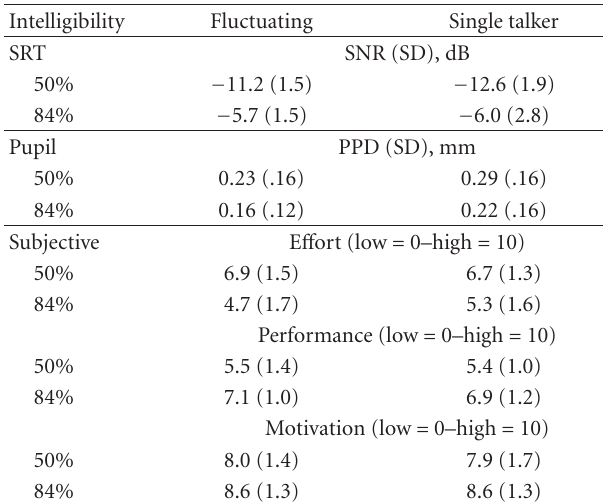
Figure 2: Pupil responses per condition averaged over subjects. The onset of the sentences is at 0 sec. The baseline is indicated as the average pupil diameter over one second preceding the start of the sentence. The area between the second and third dotted lines indicates the time window used for calculating the mean pupil